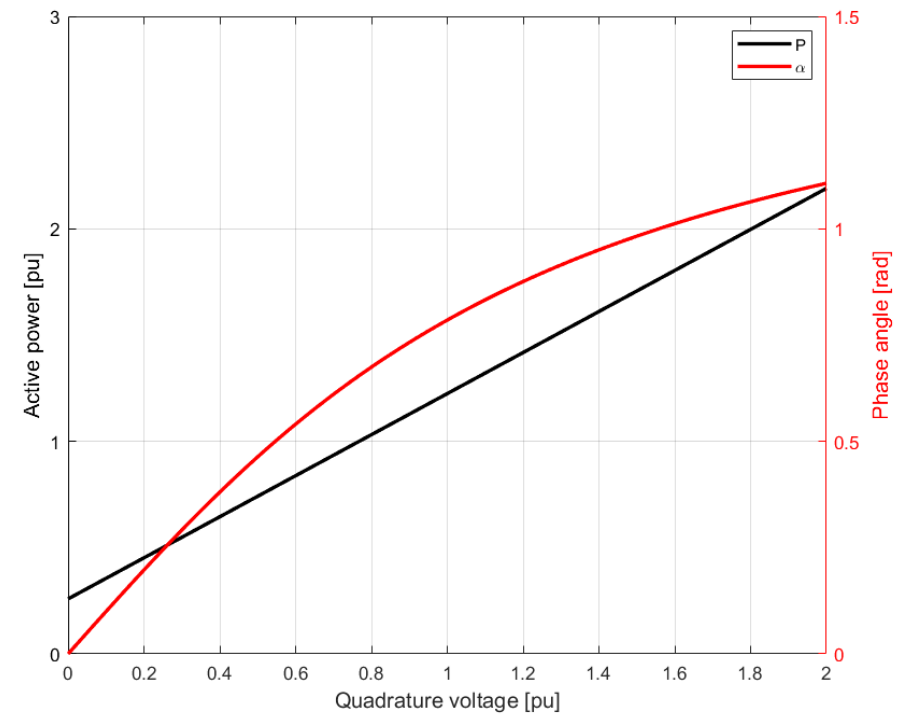
Figure 5. APST theoretical active power and phase angle curves.